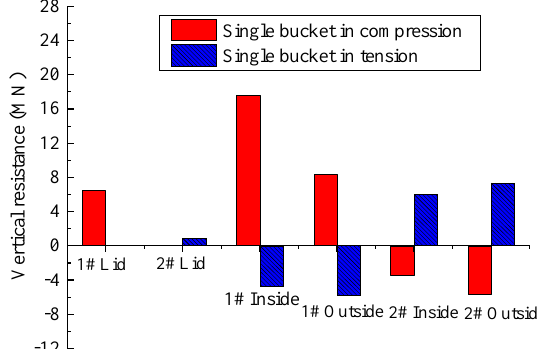
Figure 23. Vertical resistance of each part of the buckets of TSPJF under the ultimate overturning moment.